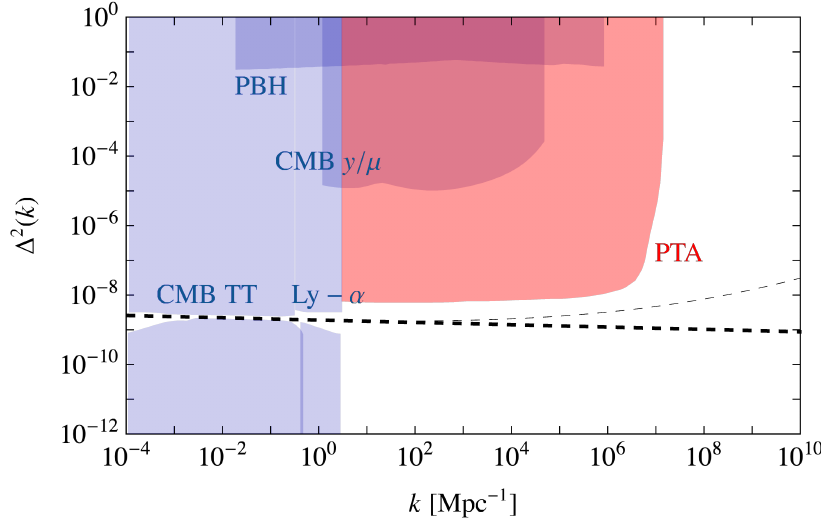
Figure 5 . Limits on the dimensionless primordial power of curvature fluctuations. PTA limits (red) are compared to constraints from a combination of CMB [40] and Ly- α [41] observables, together with limits on primordial black holes (PBH) (all in blue). The thick dashed line is the Planck best fit, assuming a constant spectral index, while the thin dashed line is the best fit obtained allowing the spectral index to have a k